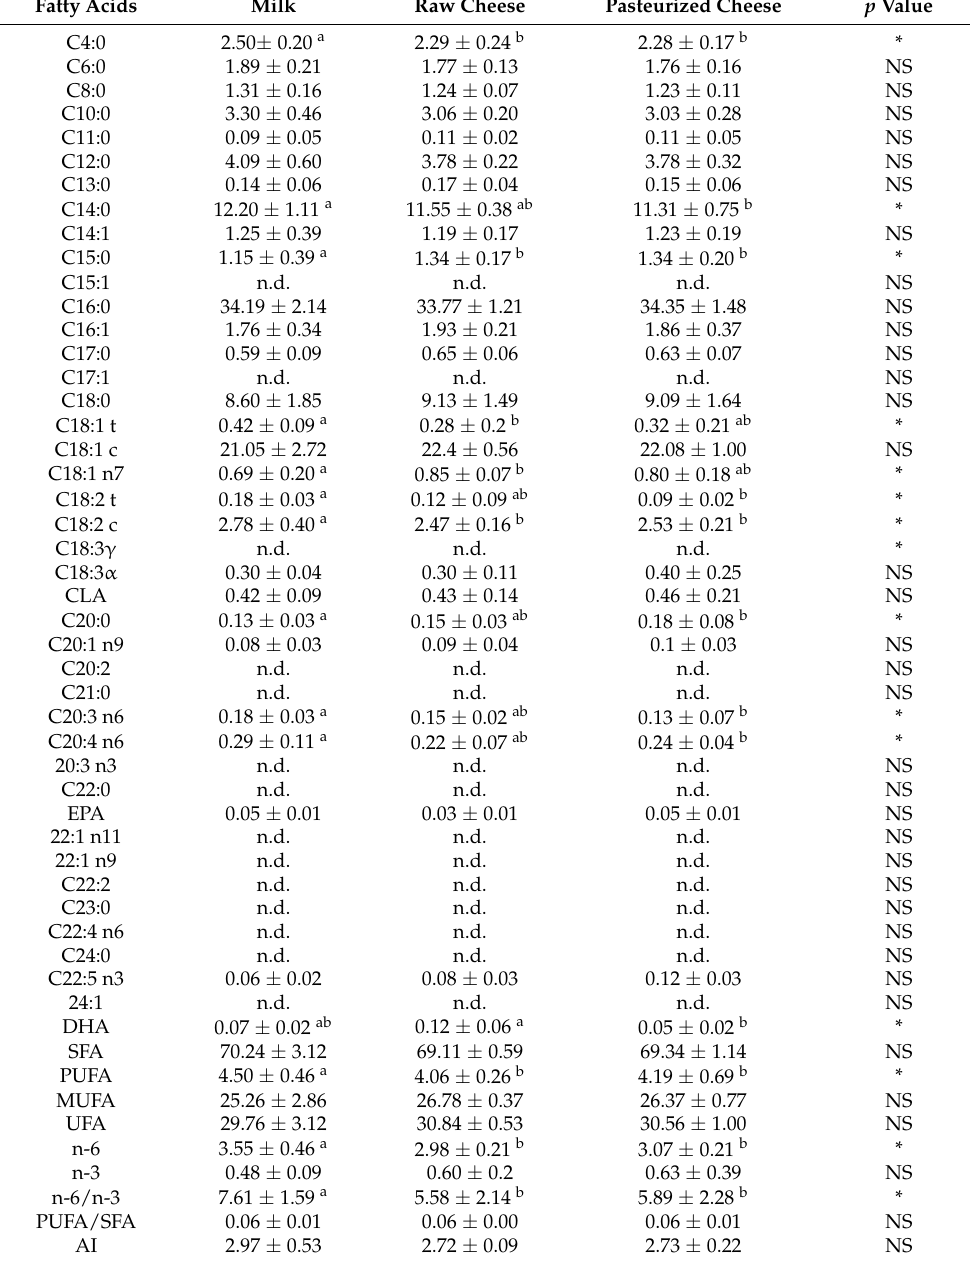
Table 6. Fatty acid composition (%) of milk, mature raw cheese and pasteurized cheese. Fatty